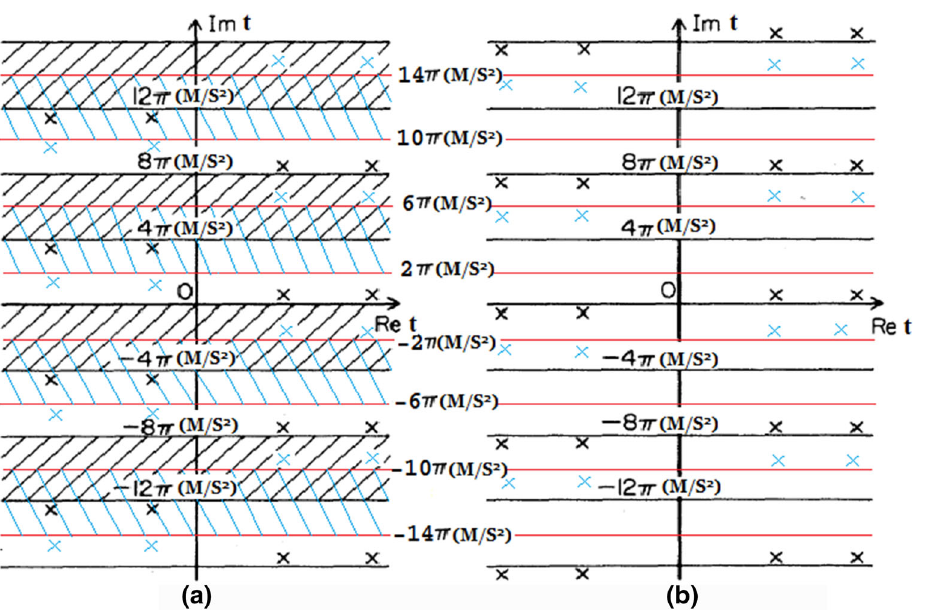
Fig. 4 Modifiedperiodicitystructure ofthepropagator due tothepres- ence of the extra degrees of freedom. The red lines and blue regions represent the analyticity regions in agreement with an observer defin-